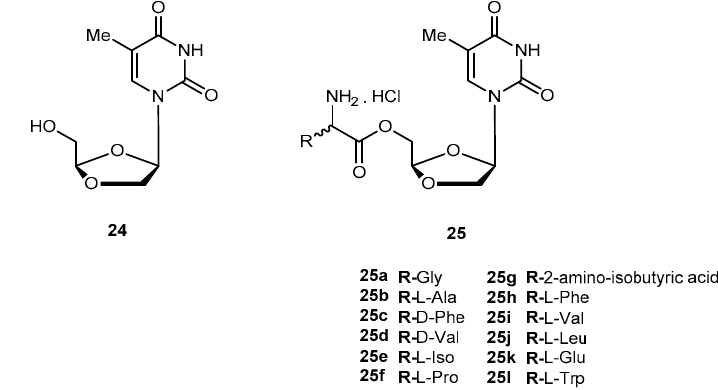
(cid:48) - O -aminoacid esters of Figure 12. Structures of 5 ′ -O-aminoacid esters of DOT. Figure 12. Structures of 5